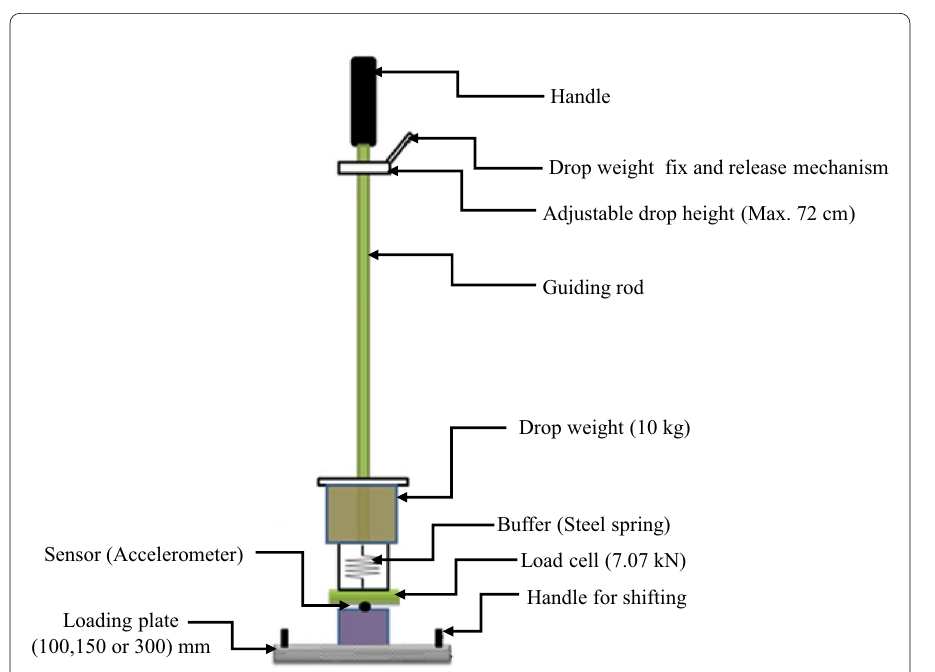
Fig. 1 Schematic view of Lightweight Deflectometer (LWD)